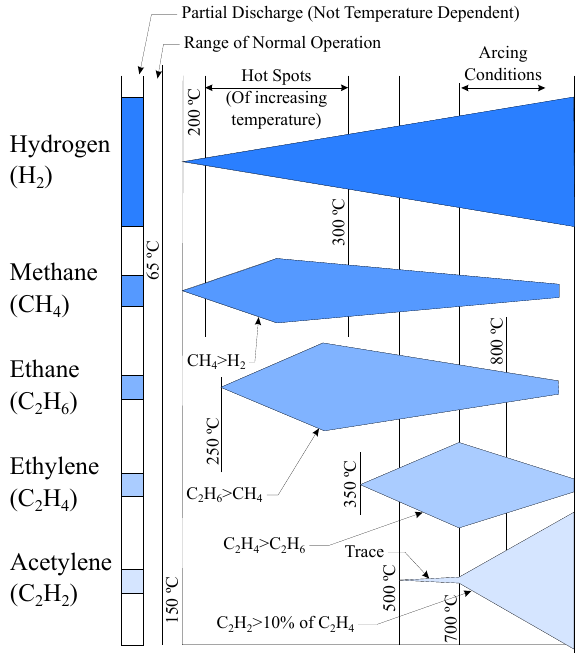
Figure 3. Gas generation based on temperature (Not to scale) [45].